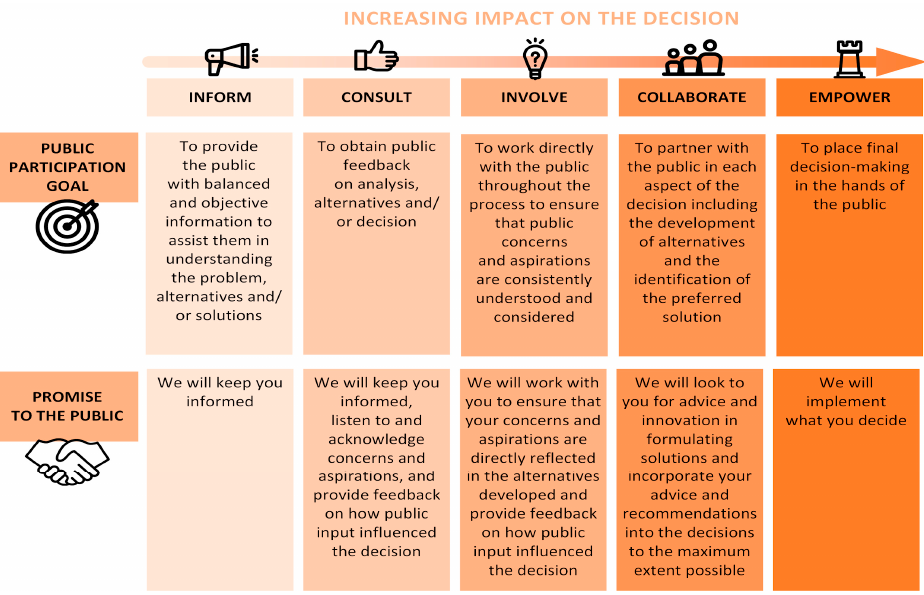
Figure 1. The Spectrum of Public Participation, adapted with permission from the International Association for Public Participation (Source: www.iap2.org, accessed on 9 October 2021, adapted by the Authors).